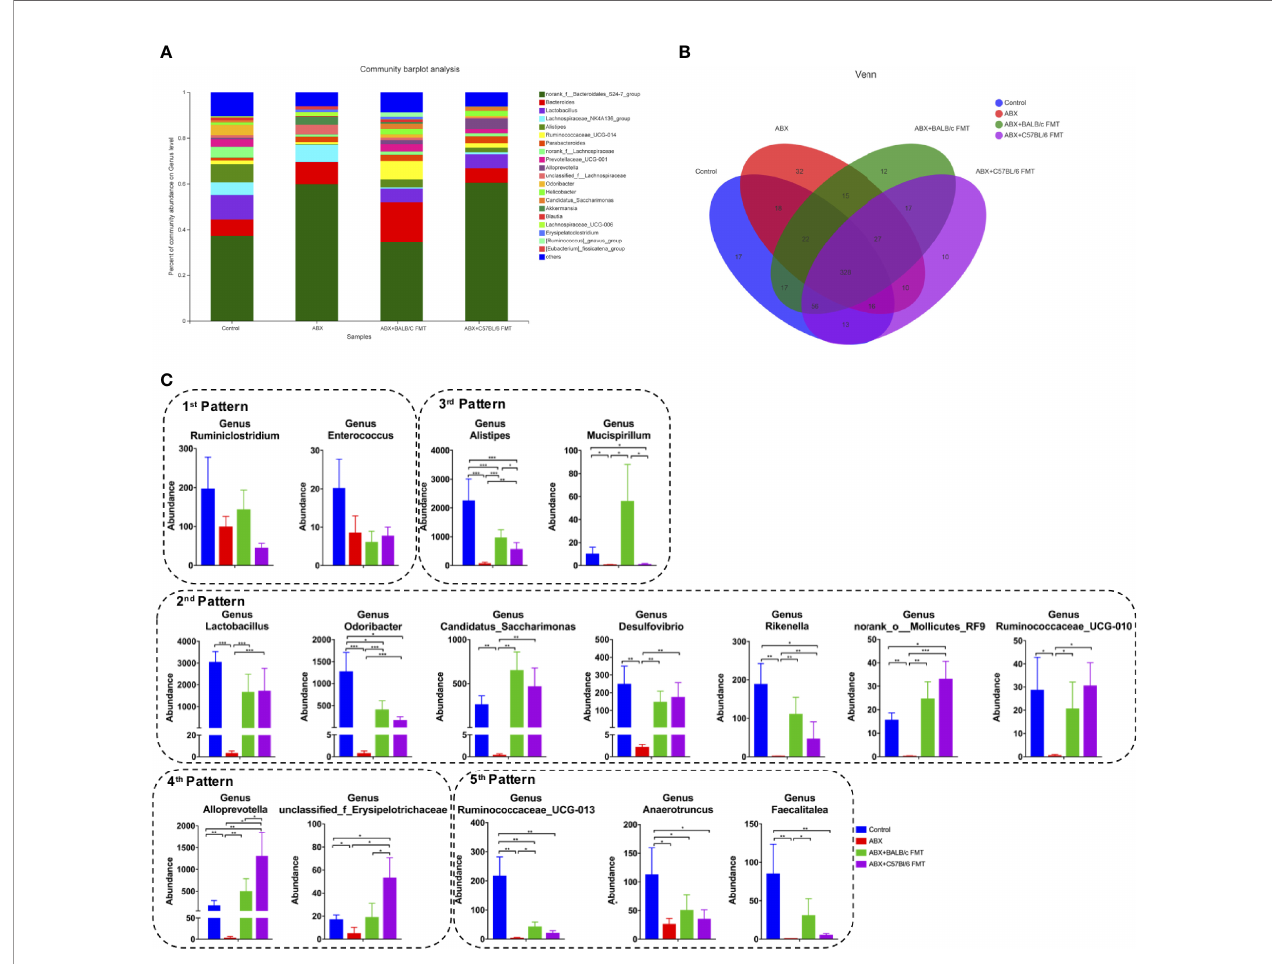
FIGURE 7 | Comparison of the gut microbiota composition at the genus level after FMT. Gut microbiota composition at the genus level (A) , a 4-way Venn diagram (B) and abundances of individual bacteria (C) after FMT (on day 35 as indicated in Figure 3A ). n = 4 in control group. n = 5 in ABX, ABX+BALB/c FMT, ABX +C57BL/6 groups. * P < 0.05, ** P < 0.01, *** P <